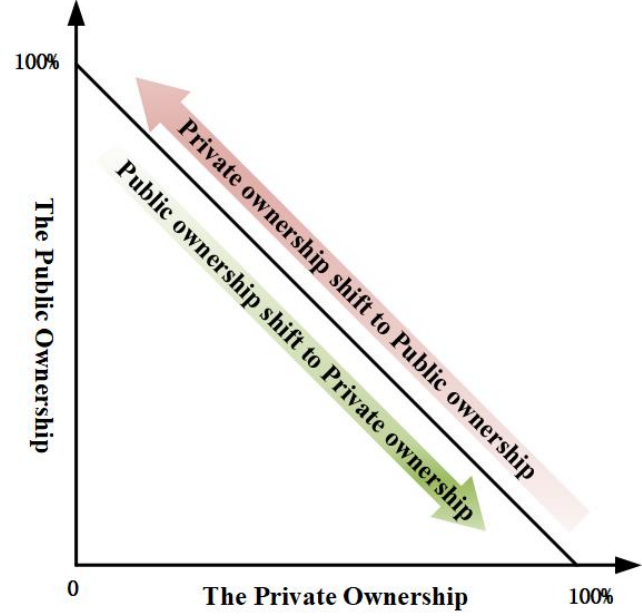
Figure 2. The real right of land between the public owner and the private owner.